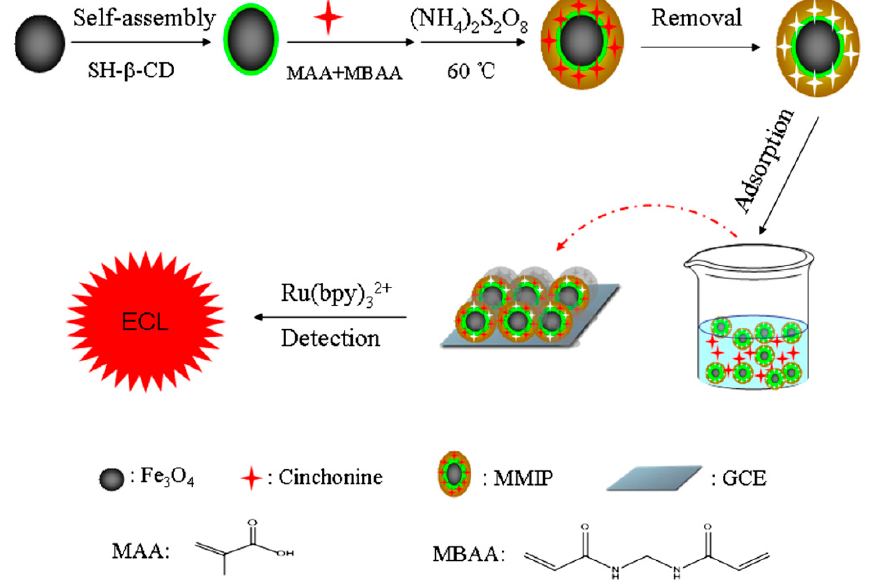
Figure7. SchematicfabricationoftheECLsensorFe 3 O 4 @Au@MIPanditsuseforcinchoninerecognition. Figure 7. Schematic fabrication of the ECL sensor Fe 3 O 4 @Au@MIP and its use for cinchonine Reproduced from [111] with permission of Wiley. recognition. Reproduced from [111] with permission of Wiley.